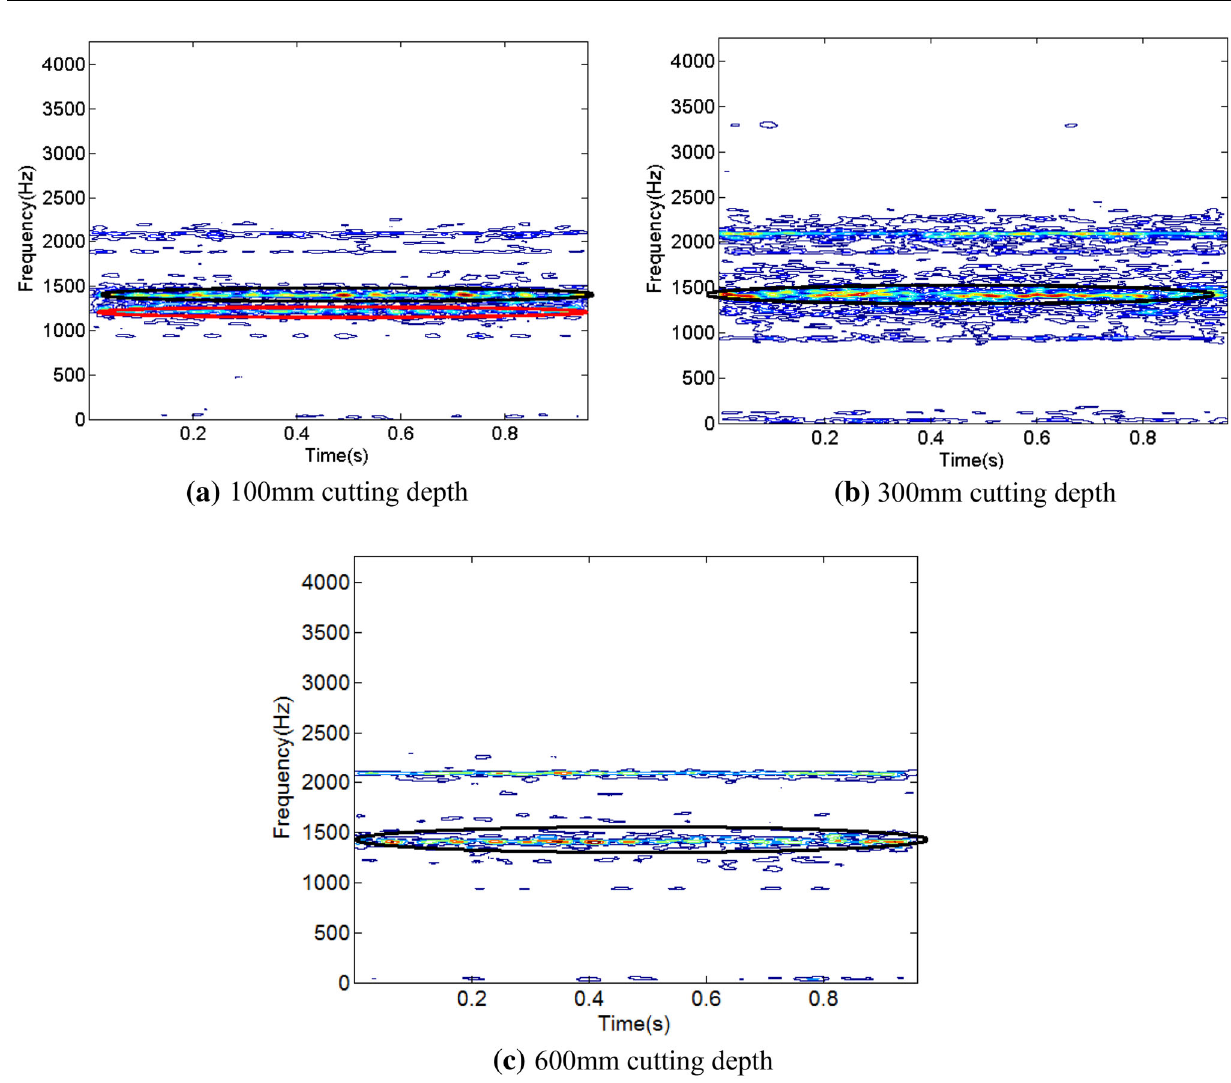
Fig. 10 Time–frequency response of planetary